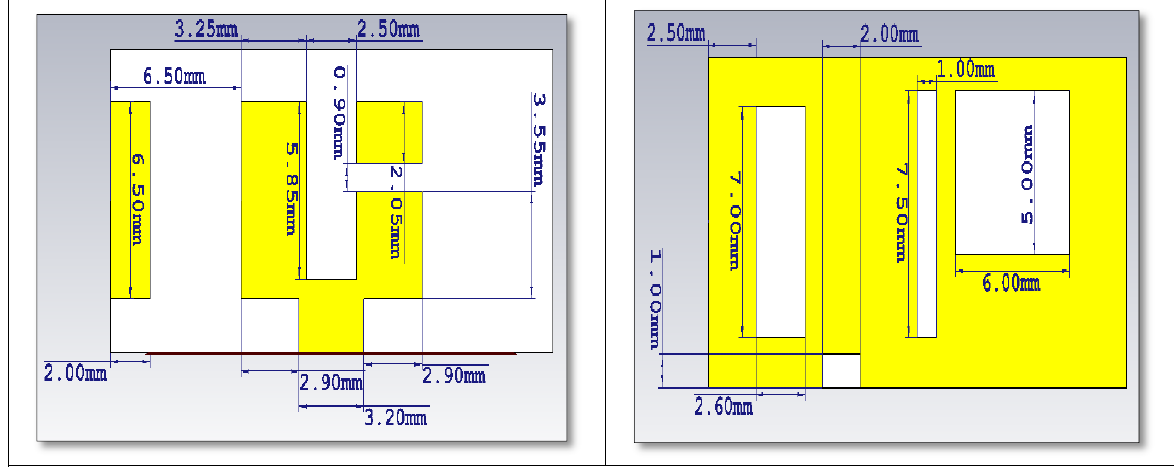
FIG. 11. SPECIFICATIONS OF THE PATCH AND GROUND